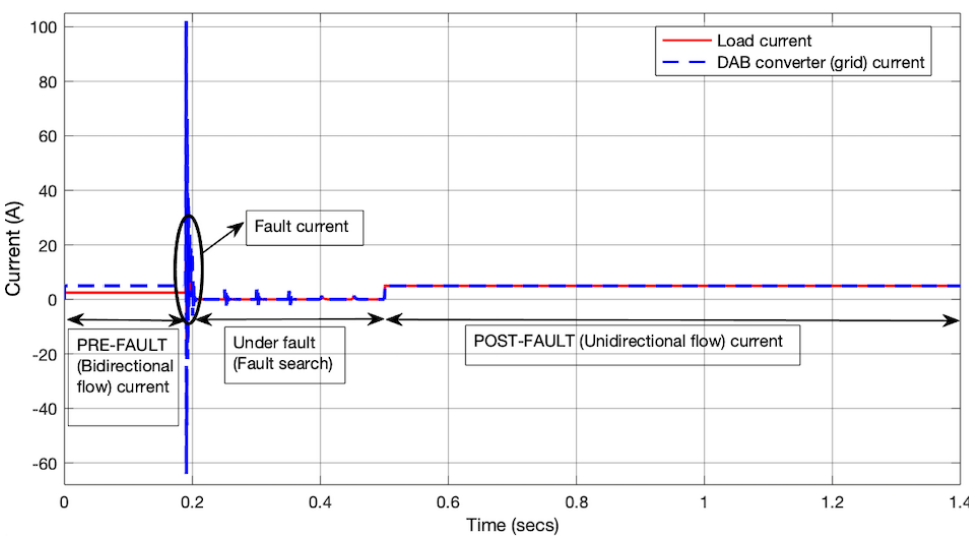
Figure 12. DAB converter (or grid) current and load current under normal or pre-fault (bidirectional current flow), fault searching, and after grid re-energisation or post-fault (unidirectional current flow) conditions.